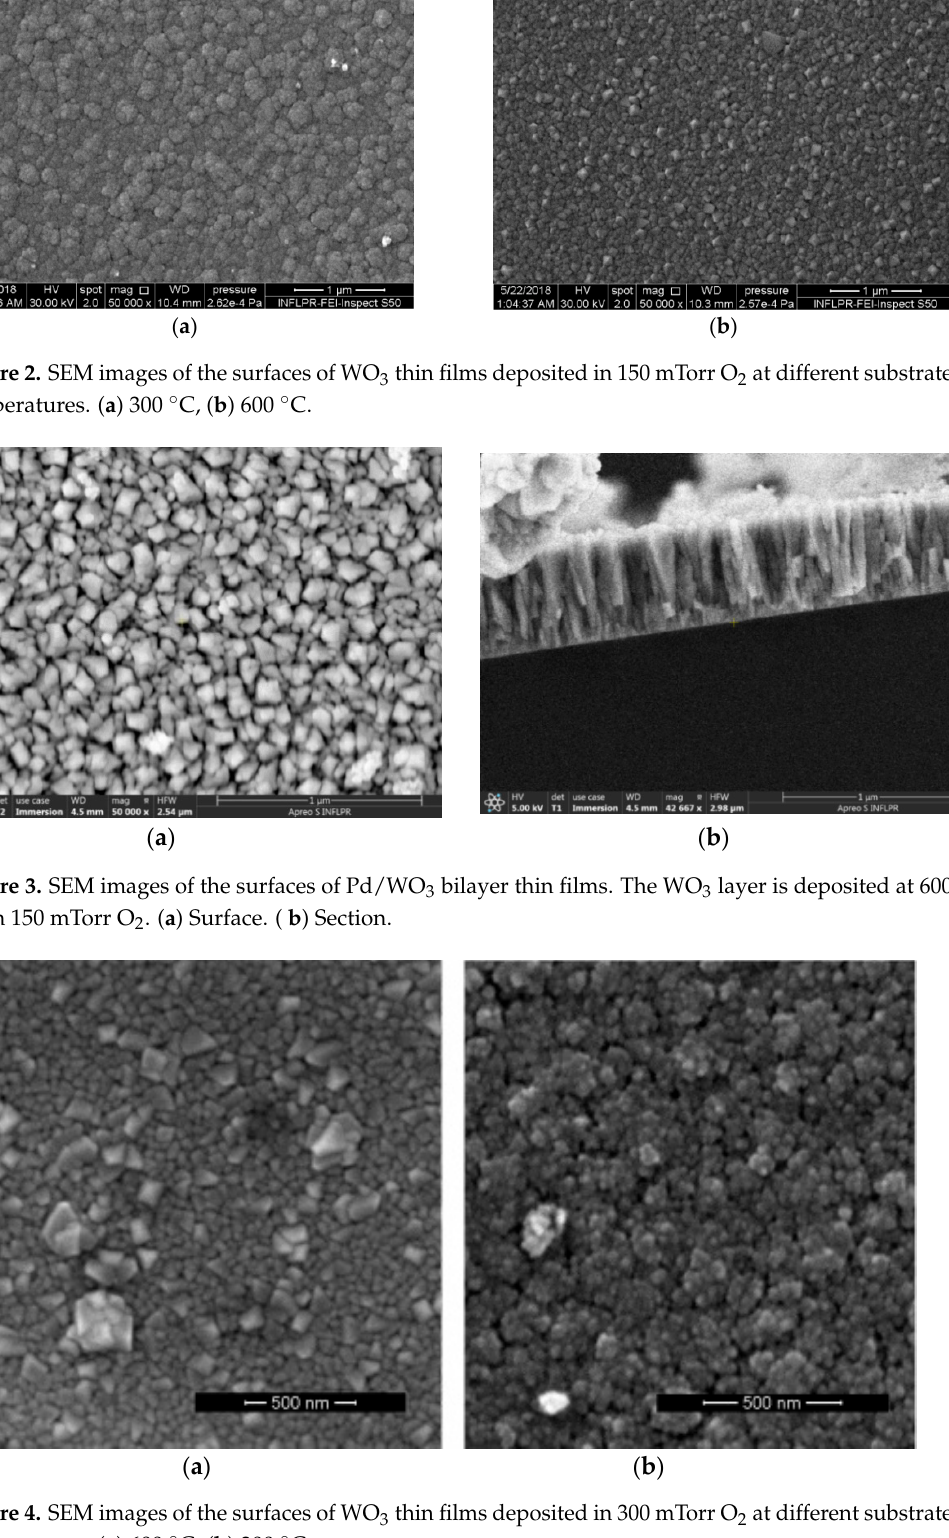
Figure 4. SEM images of the surfaces of WO 3 thin films deposited in 300 mTorr O 2 at different substrate temperatures. ( a ) 600 °C; ( b ) 300 °C.